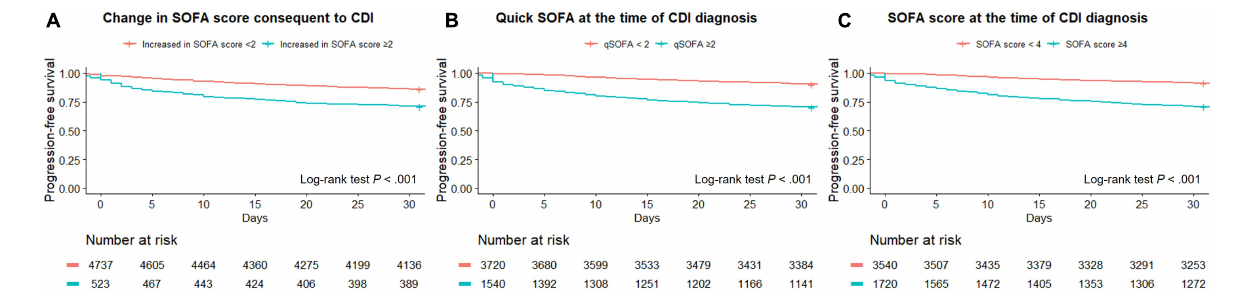
Frontiers in Microbiology |